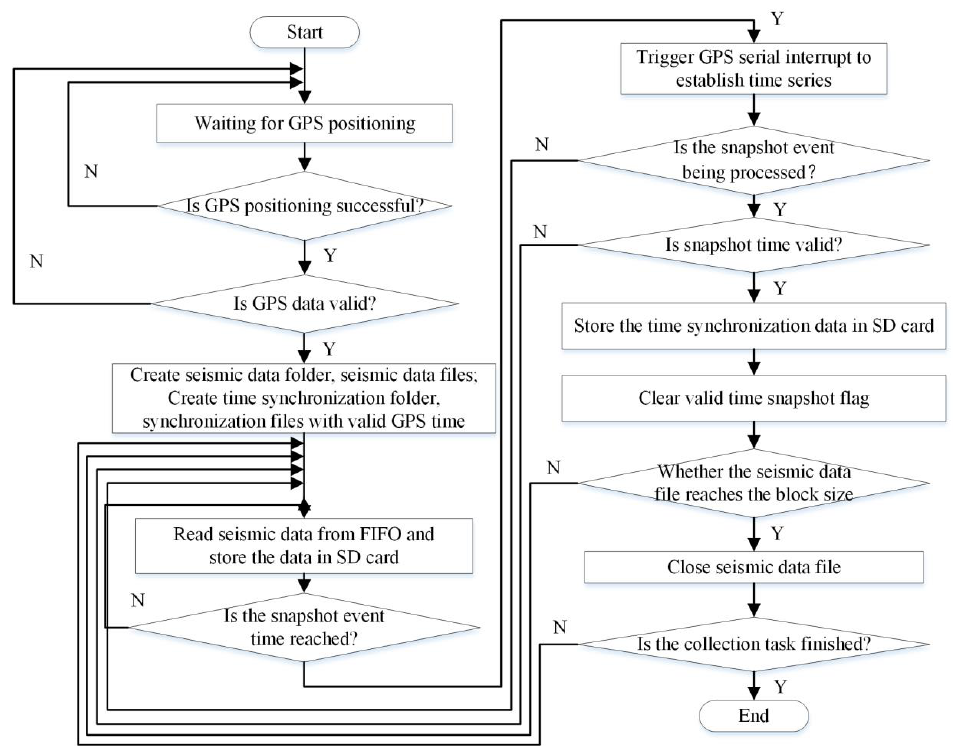
Figure 9. The workflow of the main program.